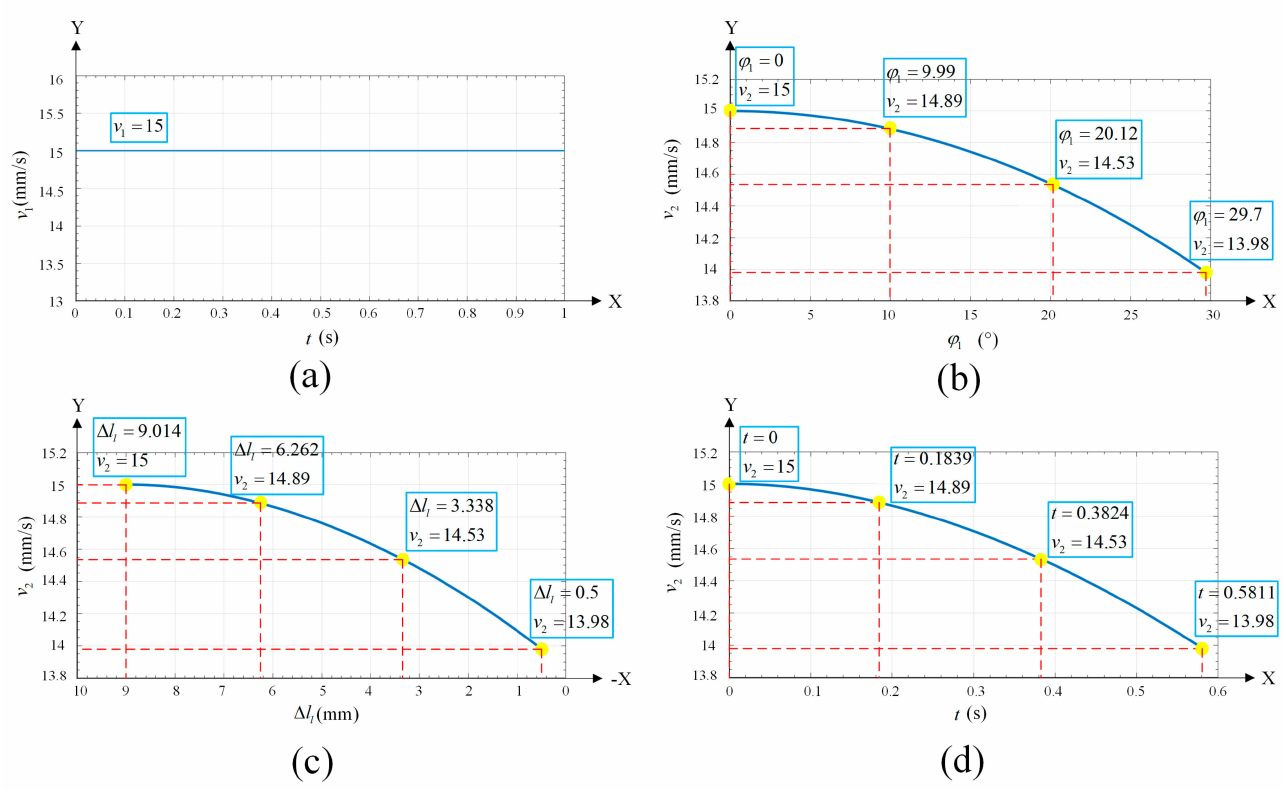
Figure 11. Welding torch inclination ϕ 1 - ∆ l l curve after planning. Furthermore, the highlighted points represent the serval inclination states of the welding torch during the weaving process.